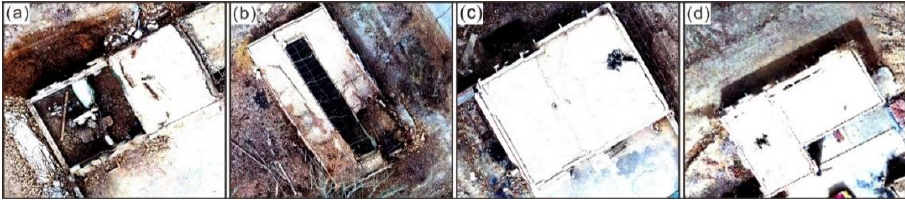
Figure 5. Examples of UAV images. ( a ) Collapsed building; ( b ) Severely damaged building; ( c ) Lightly damaged building; ( d ) Undamaged building. ( c ) Lightly damaged building; ( d ) Undamaged